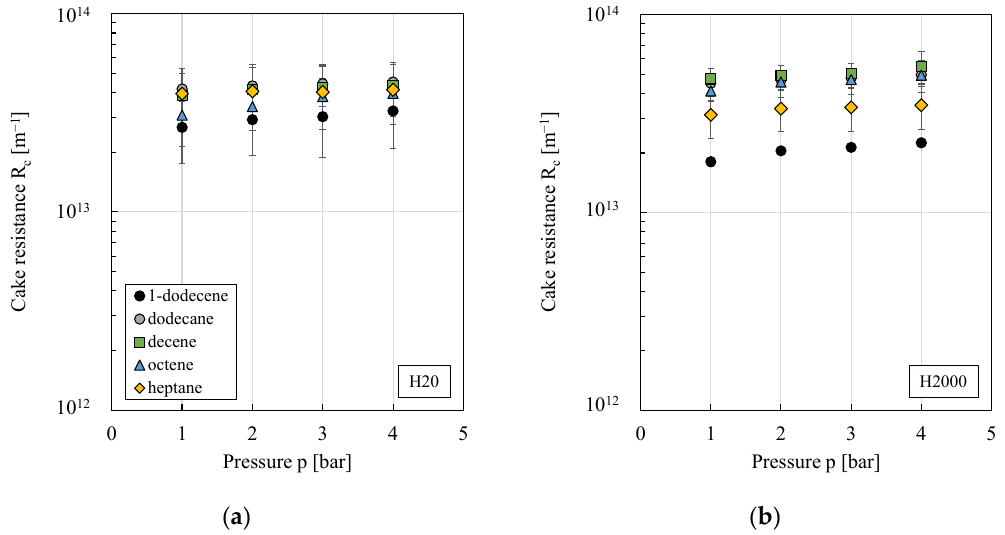
Figure 10. Cake resistance against pressure for w/o PEs prepared using different organic solvents and stabilized by particle type ( a ) H20 or ( b ) H2000. All pressure stepping experiments were conducted at least in duplicate and mean values are shown. Error bars represent the standard deviation. Where not visible, error bars are smaller than the symbol size.